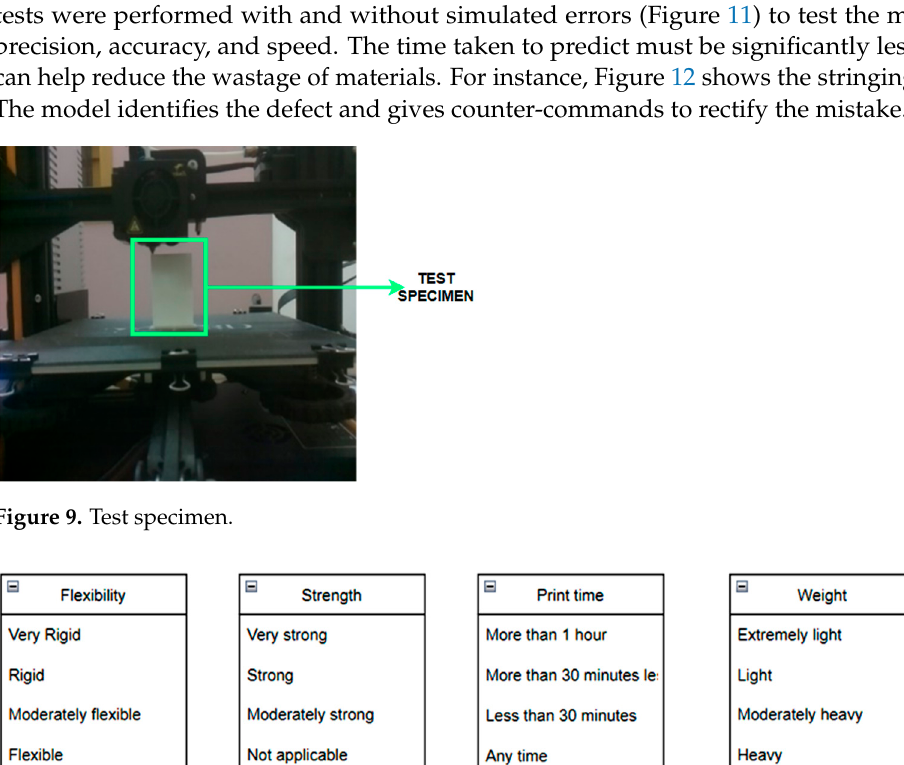
Figure 11. Live testing results . Figure 12. Live testing results with stringing error . 5. Conclusions The prediction of optimal input parameters for 3D printing is made by training a machine learning model using the results obtained from finite element analysis. The in ‐ fluence of parameters like material, wall thickness, infill pattern, infill density, nozzle diameter, and layer thickness was investigated using DOE and ANOVA approaches. Based on the former, 25 combinations of those mentioned above were tested, and total deformation, maximum stress, and safety factors were estimated. ANOVA was used to obtain the regression, which was then validated by comparing the values with those ob ‐ tained from finite element analysis. The regression equations (Equations (1)–(3)) and other important data, including images of simulated errors, were used to train the ma ‐ chine ‐ learning model. The InceptionV3 ‐ based algorithm achieved a precision of 100% and an accuracy of 97%. This algorithm helps avoid a similar experiment to predict the optimal input parameters for a given requirement. The algorithm is built so that it re ‐ quires minimum computational power. Therefore, it can be incorporated into all major manufacturing industries.